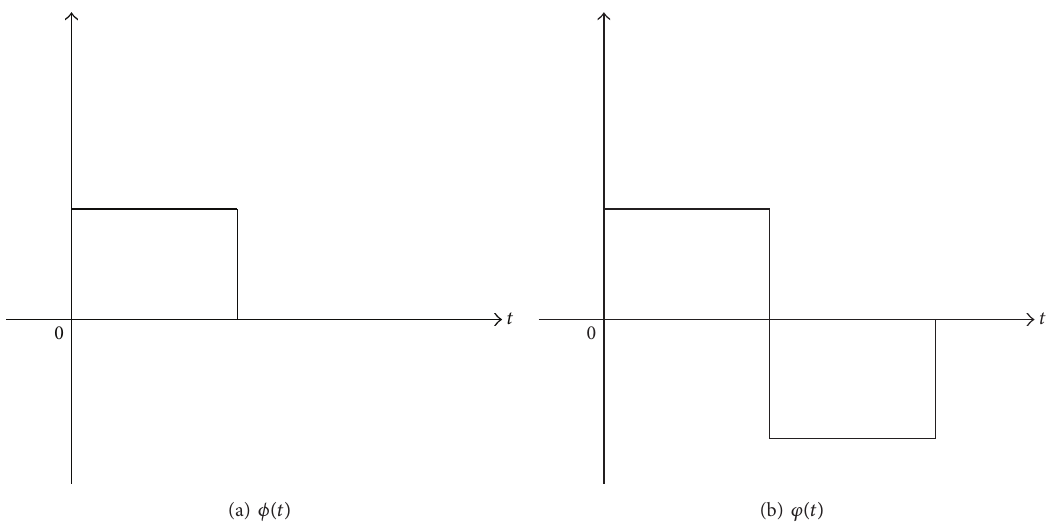
Figure 3: Haar scaling function and